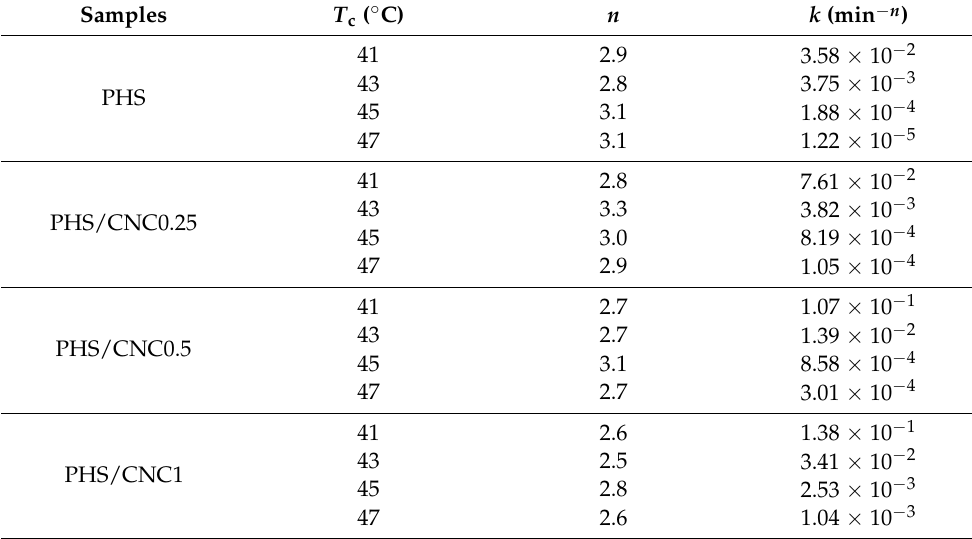
Table 1. Summary of Avrami parameters of PHS and PHS/CNC composites. Samples